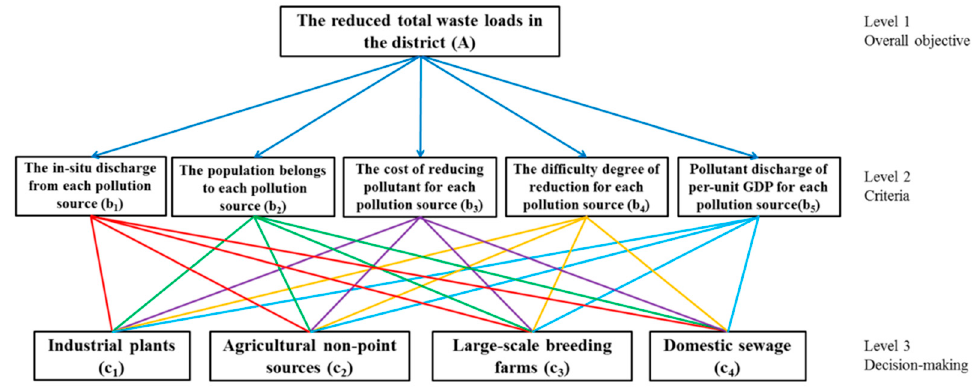
Figure 3. The hierarchy analysis framework of optimization criteria.